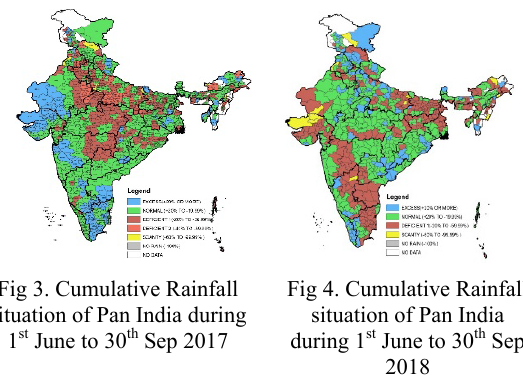
Fig 3. Cumulative